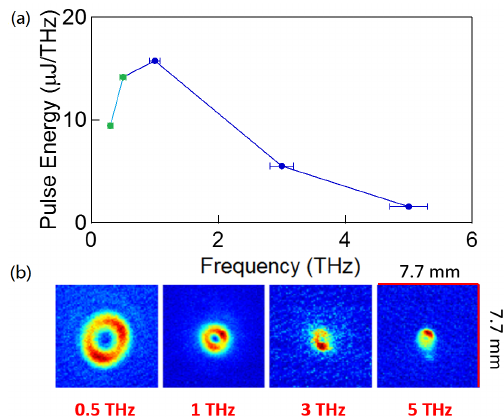
Figure 3. Broadband THz generation: ( a ) spectral distribution sampled by THz filters. The error bars represent the bandwidth of the bandpass filters; ( b ) Transverse intensity distributions of CTR in the focus of the parabolic mirror for different wavelength. Since the used power meter (THz-I-BNC GENTEC-EO) is not calibrated for frequencies below 0.61 THz, the measured energy for frequencies below this value is a qualitative assessment.